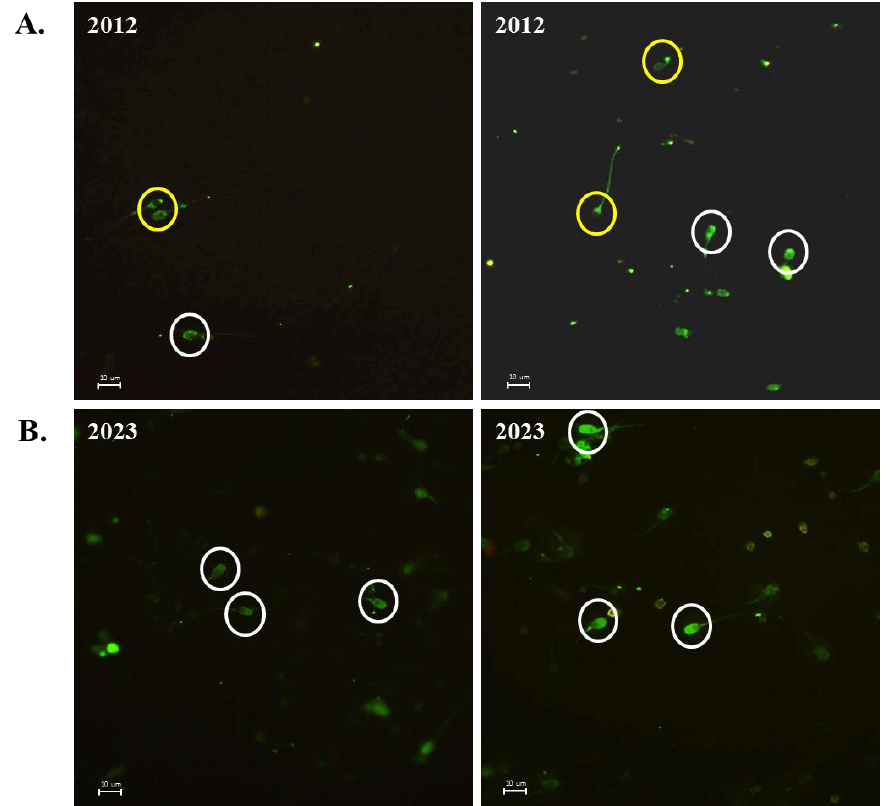
Figure 5. Comparison of acrosome formation in sperm from boar number 2012 and 2023. Acrosome was stained with FITC-PSA probe. (A) sperm from boar 2012, and (B) sperm from boar 2023. Yellow circles show the spermatozoa with acrosome defect and white circles contain the sperm head formed with normal acrosome (FITC-PSA, ×400). FITC-PSA, Fluorescein isothiocyanate- Pisum sativum agglutinin